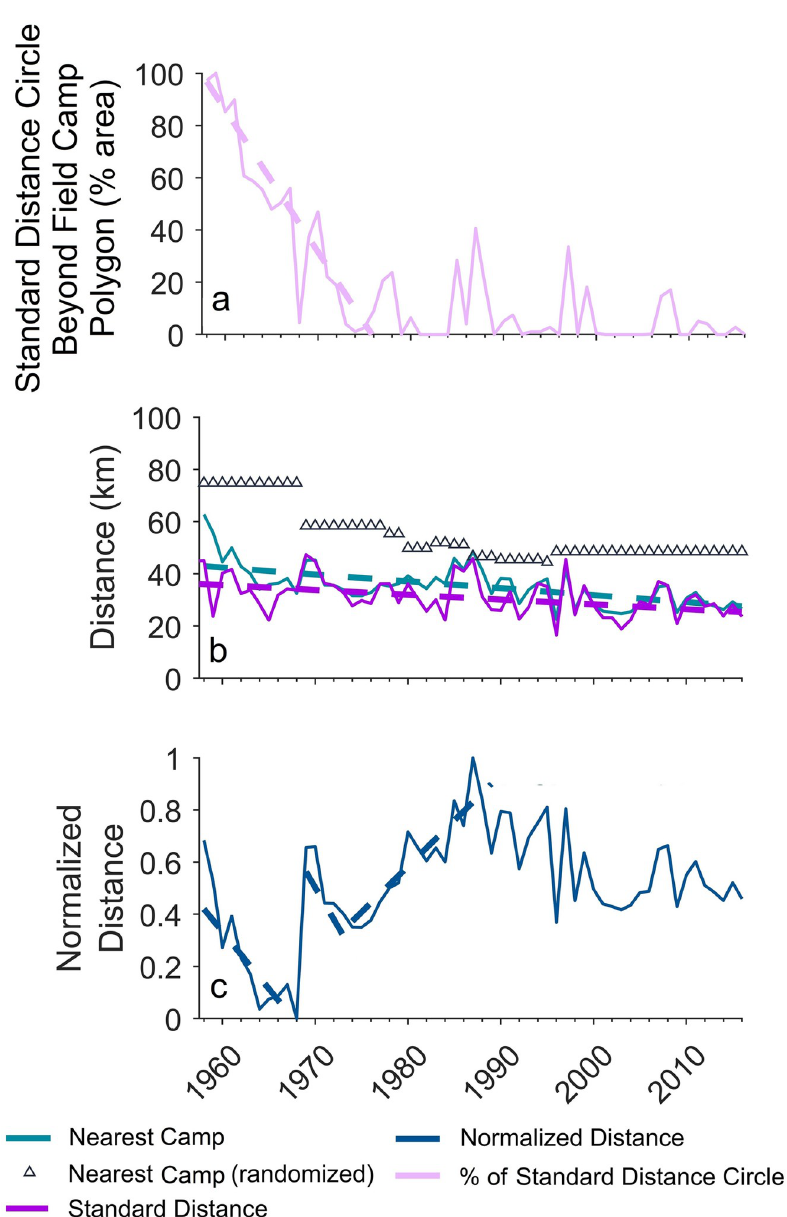
Fig 5. Time series of field camp proximity and overlay analyses. Only statistically significant (p < 0.05) Sen’s slopes (dashed lines) are shown. a) Percent area of study site standard distance circle outside of field camp bounding polygon; b) Distance to the nearest field camp, standard distance of study sites, and randomized distance to the nearest field camp; c) Distance to the nearest field camp detrended from randomized distance and